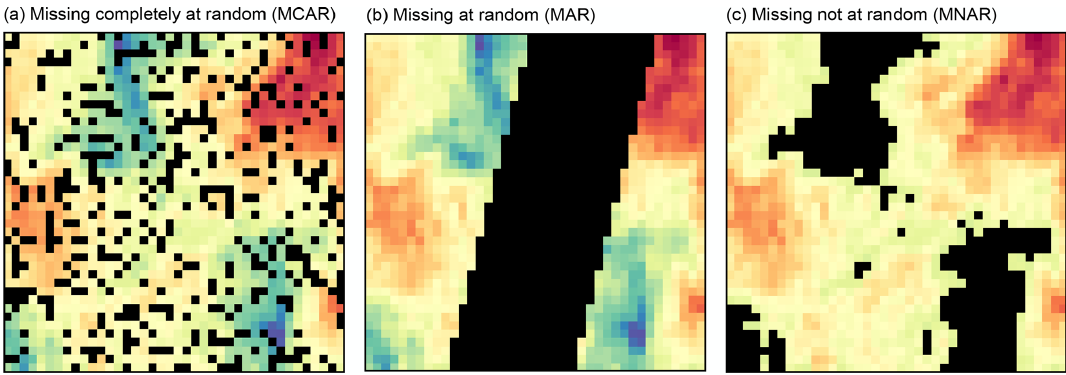
Figure 1. Examples of the three patterns in which values can be missing: (a) missing completely at random (MCAR), (b) missing at random (MAR), and (c) missing not at random (MNAR). The MCAR missingness is created by setting randomly drawn grid points to be missing. For MAR missingness, a patch of the data was removed to mimic satellite swaths. In MNAR missingness, all values below a certain threshold are